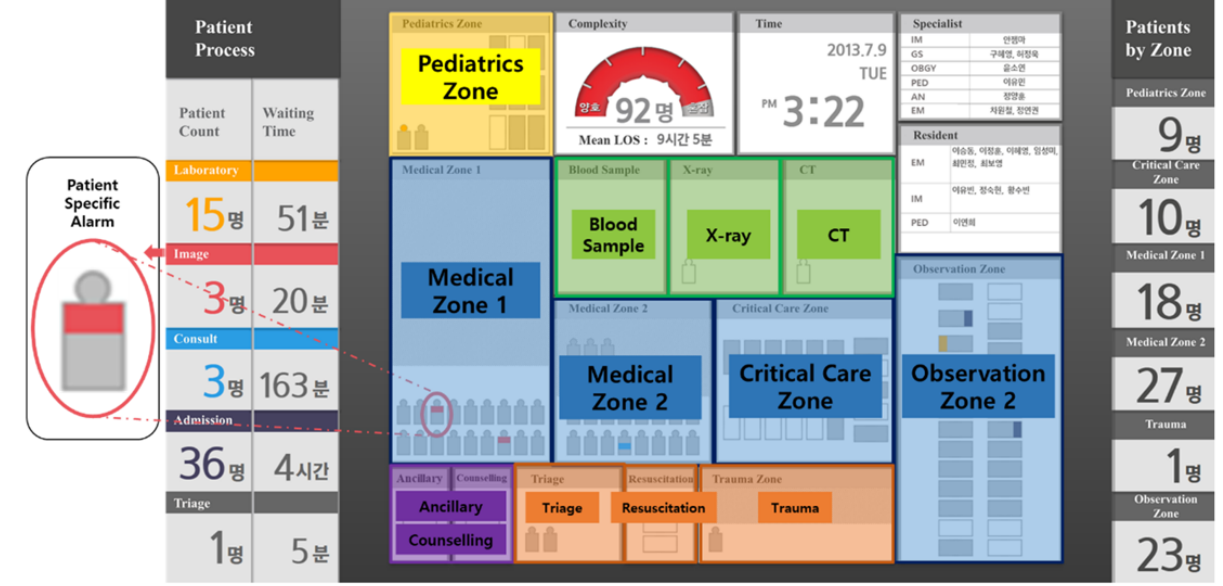
Figure 3. The first version of the emergency department